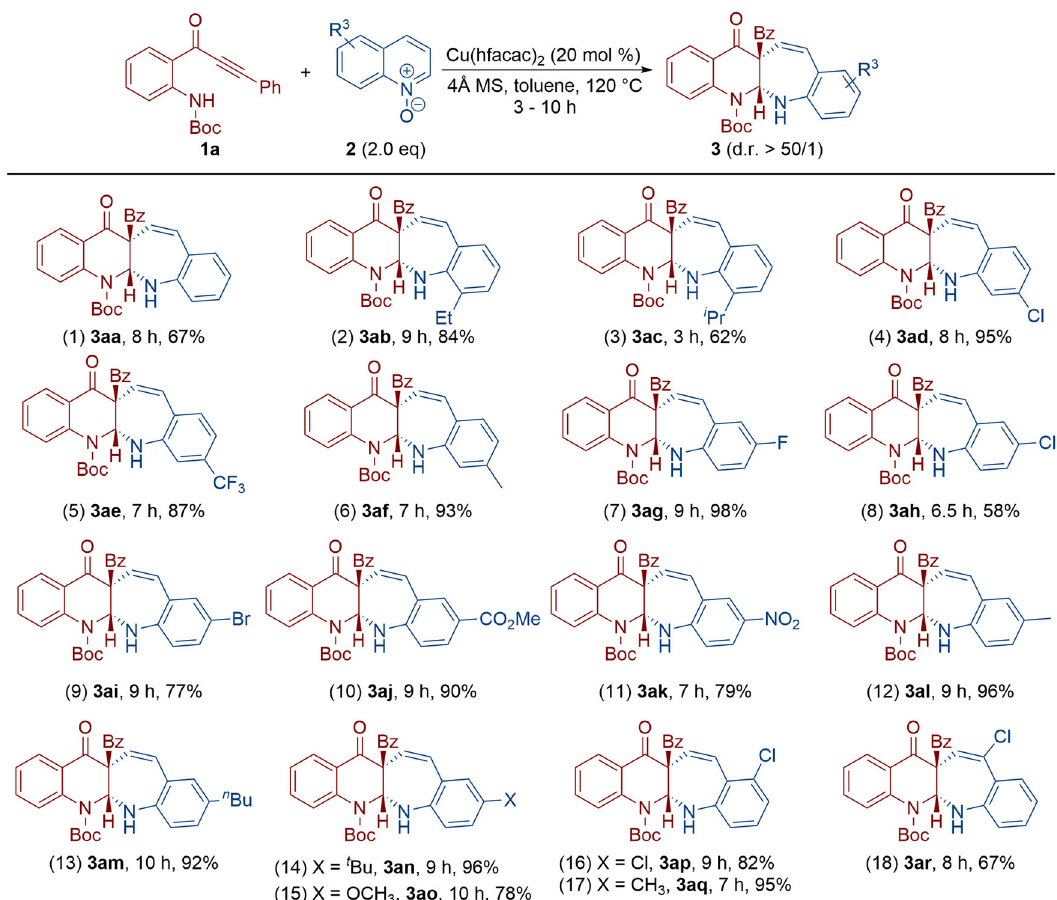
Fig. 3 Reaction scope with different quinoline N -oxides 2. Reaction conditions: [ 1 ] = 0.05 M; yields are those for the isolated